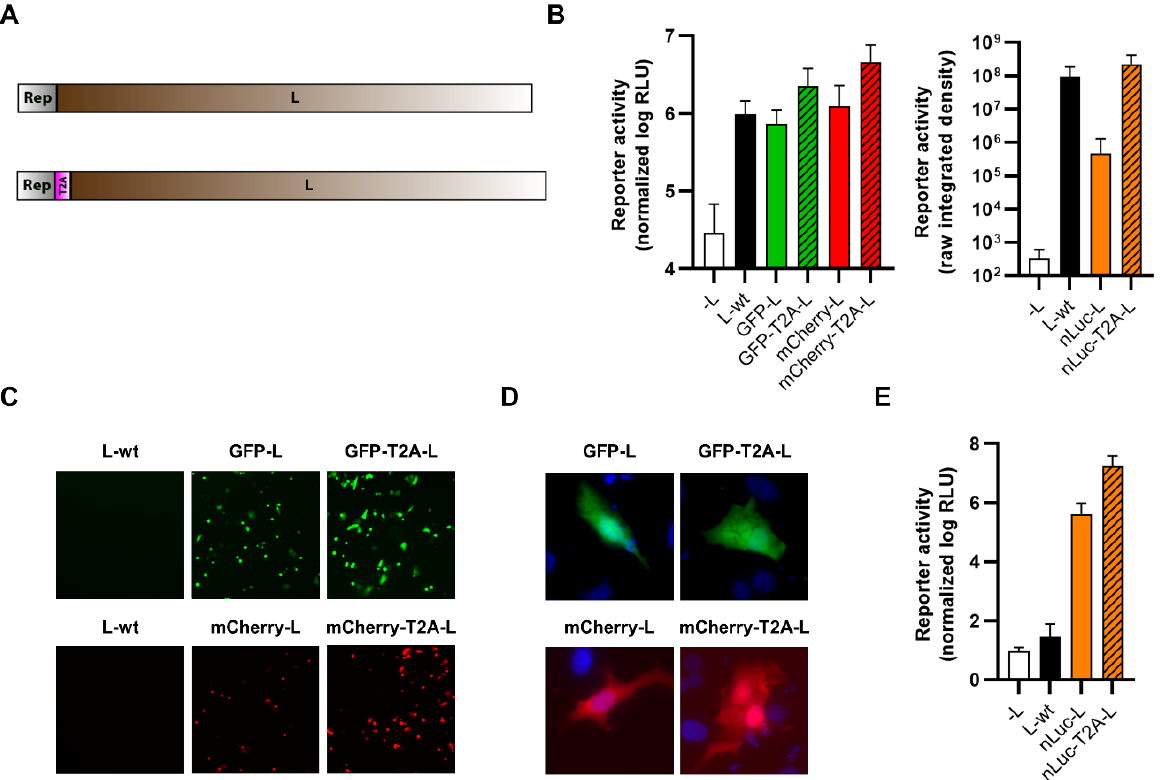
Figure 8. N-terminal fusion of TCRV L to reporter proteins. ( A ) Schematic. Reporter proteins were N-terminally fused directly to TCRV L (top) or separated by a T2A site (bottom). ( B ) Minigenome activity. BSR-T7/5 cells were transfected with plasmid components for either a nLuc-based minigenome assay (left), or a GFP-based minigenome assay (right). For nLuc-based minigenome assays (left), cells were lysed after 48 h and both nLuc and FLuc activities were measured. Results are shown as the mean ± SD of the log of nLuc activity normalized to FLuc activity from three independent experiments. For GFP-based minigenome assays (right), pictures of each well were taken and used to measure the raw integrated density in the GFP channel. Results are shown as the mean ± SD of three independent experiments. ( C ) Reporter activity (GFP/mCherry). Pictures of cells transfected as in ( B ) were taken 48 h post-transfection at 10 × magnification. Results are shown as representative images from one experiment out of two independent experiments. ( D ) Reporter localization. Pictures of cells transfected as in ( B ) were taken 24 h post-transfection at 63 × magnification after fixation and DAPI staining. Results are shown as representative images from one experiment out of two independent experiments. ( E ) Reporter activity (nLuc). Cells transfected as in ( B ) were lysed 48 h post-transfection, and nLuc activity in lysates was measured. Results are shown as mean ± SD of three independent